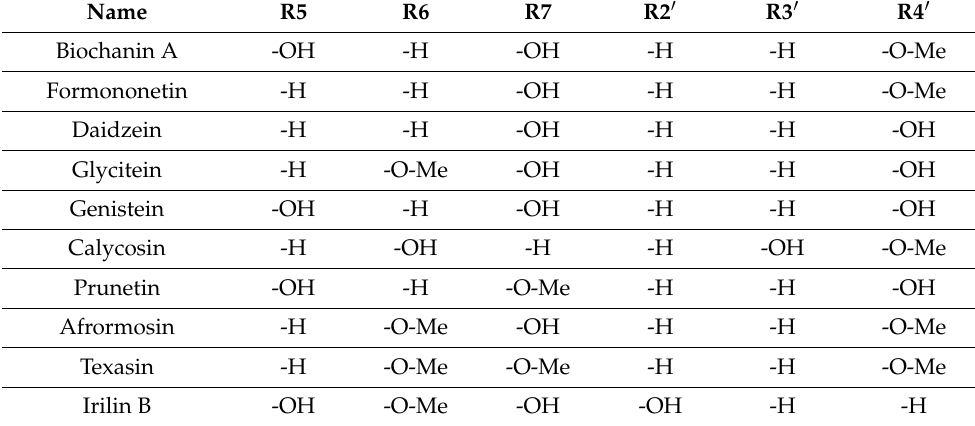
Table 1. Isoflavones reported in clover plants and honey (see Figure 1 for general